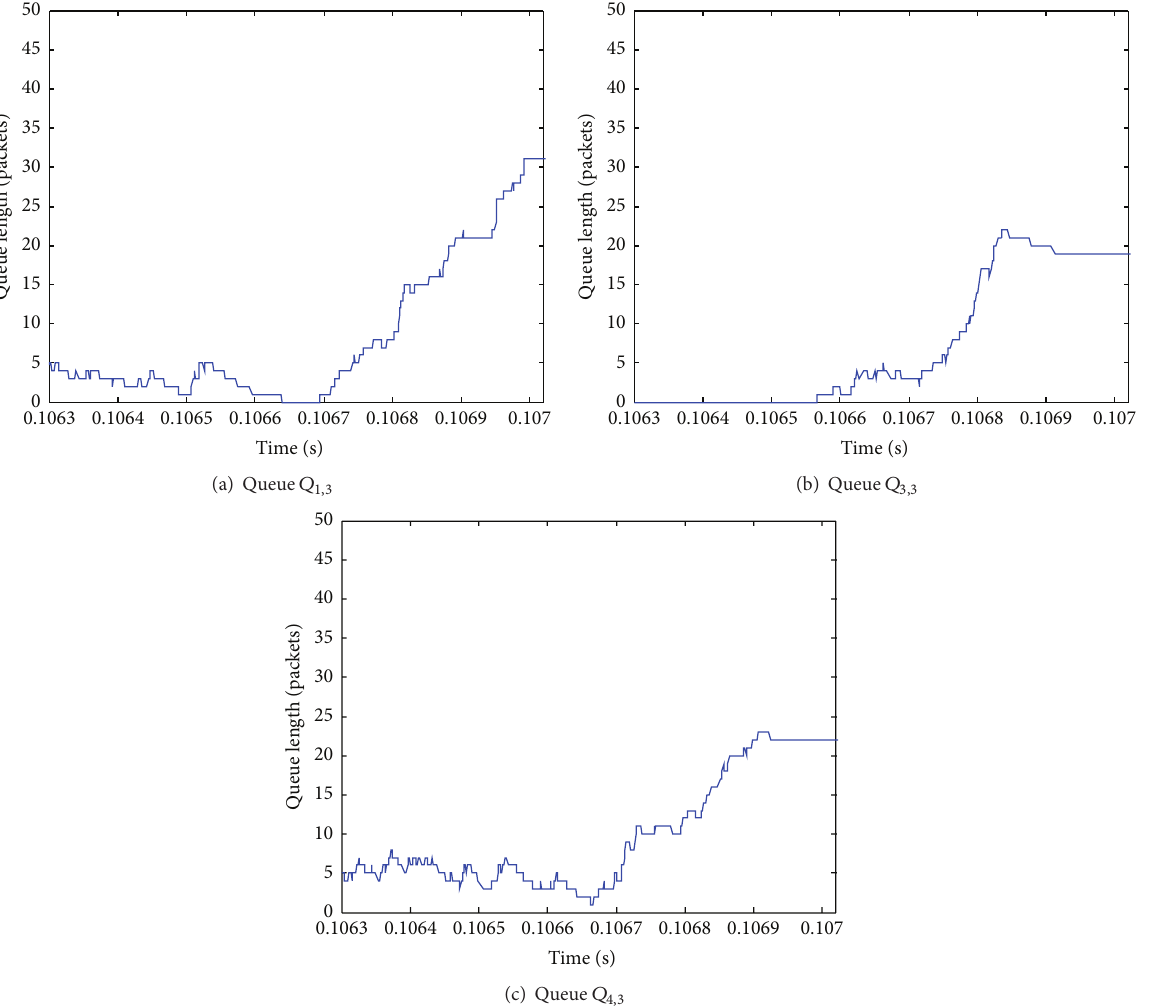
Figure 7: Length evolution of the inside-function queues 𝑄 𝑚,3 , for each 𝑚 ∈ [1, 𝑀]